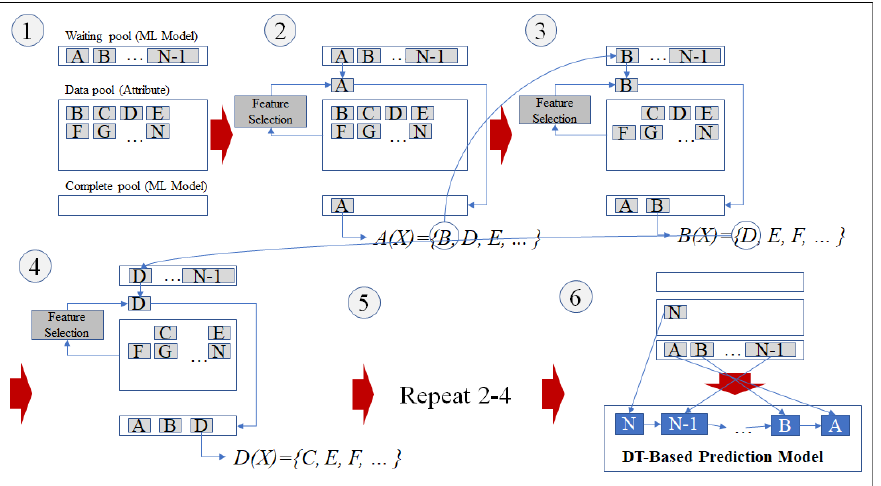
Figure 5. Method for the DT-based prediction model.